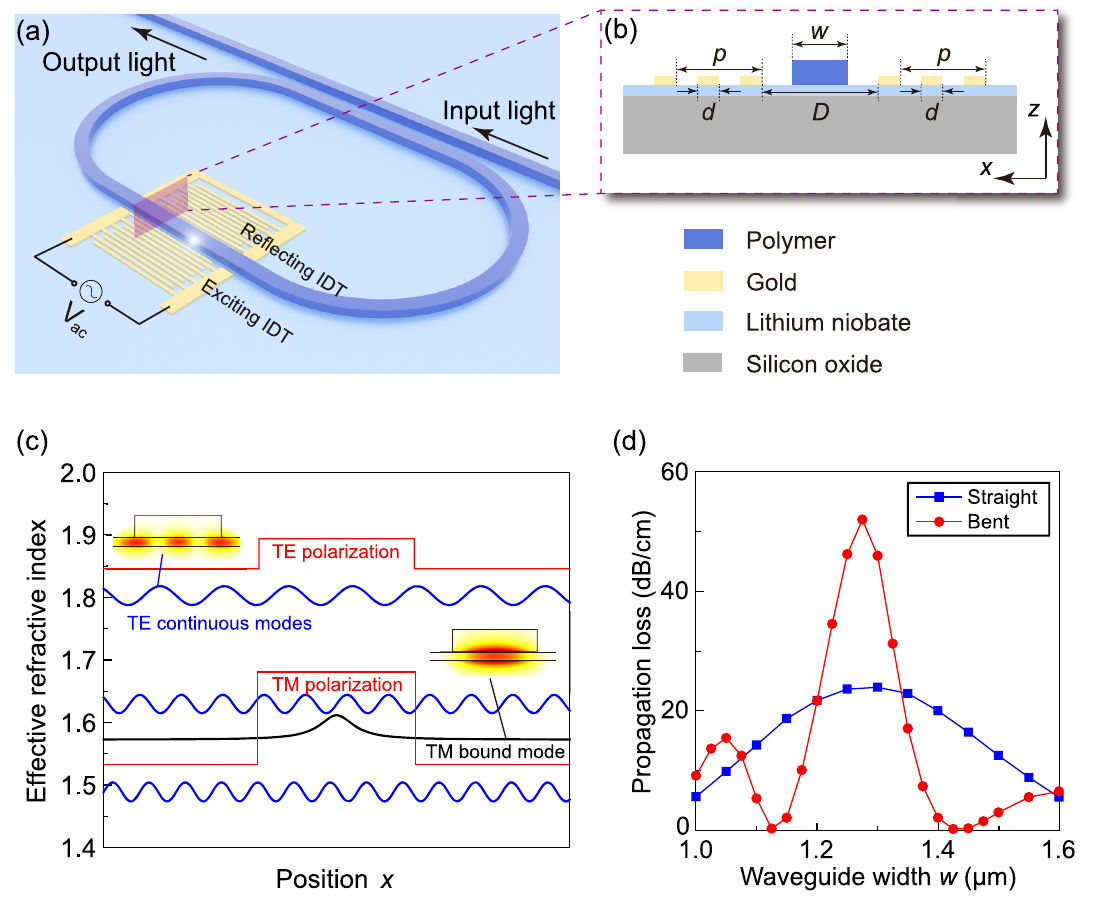
Figure 1: (a) Illustration of the device for acousto-optic modulation. (b) Cross section of the acousto-optic modulation region, with dimension labels. w is the width of the polymer waveguide, p is the period of the IDTs, d is the width of the IDT fi ngers, and D is the distance between the two IDTs. (c) Effective refractive index distributions for the TE- and TM-polarized modes in the waveguide structure in (b). The insets show the electric fi eld | E | pro fi lesoftheTEcontinuousmodeandtheTMboundmode.(d)Calculatedpropagationlossofastraightwaveguideandabent waveguide with the bend radius of 150 μ